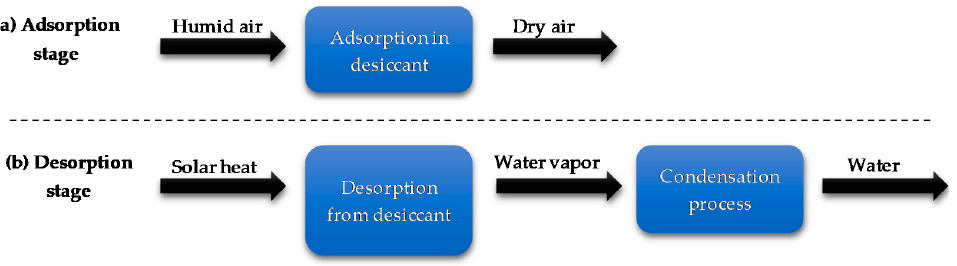
Figure 8. Adsorption/desorption stages of SPAWH.